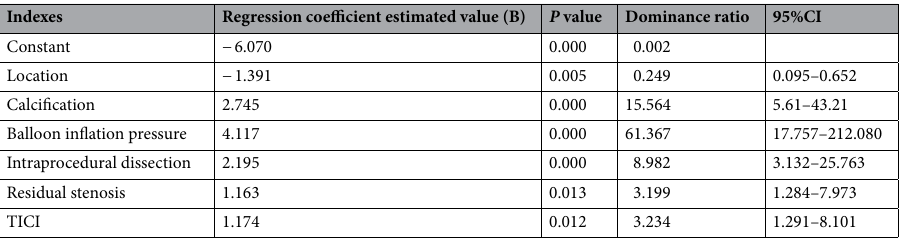
Table 3. Regression model of instent restenosis based on imaging and clinical features of lesions.